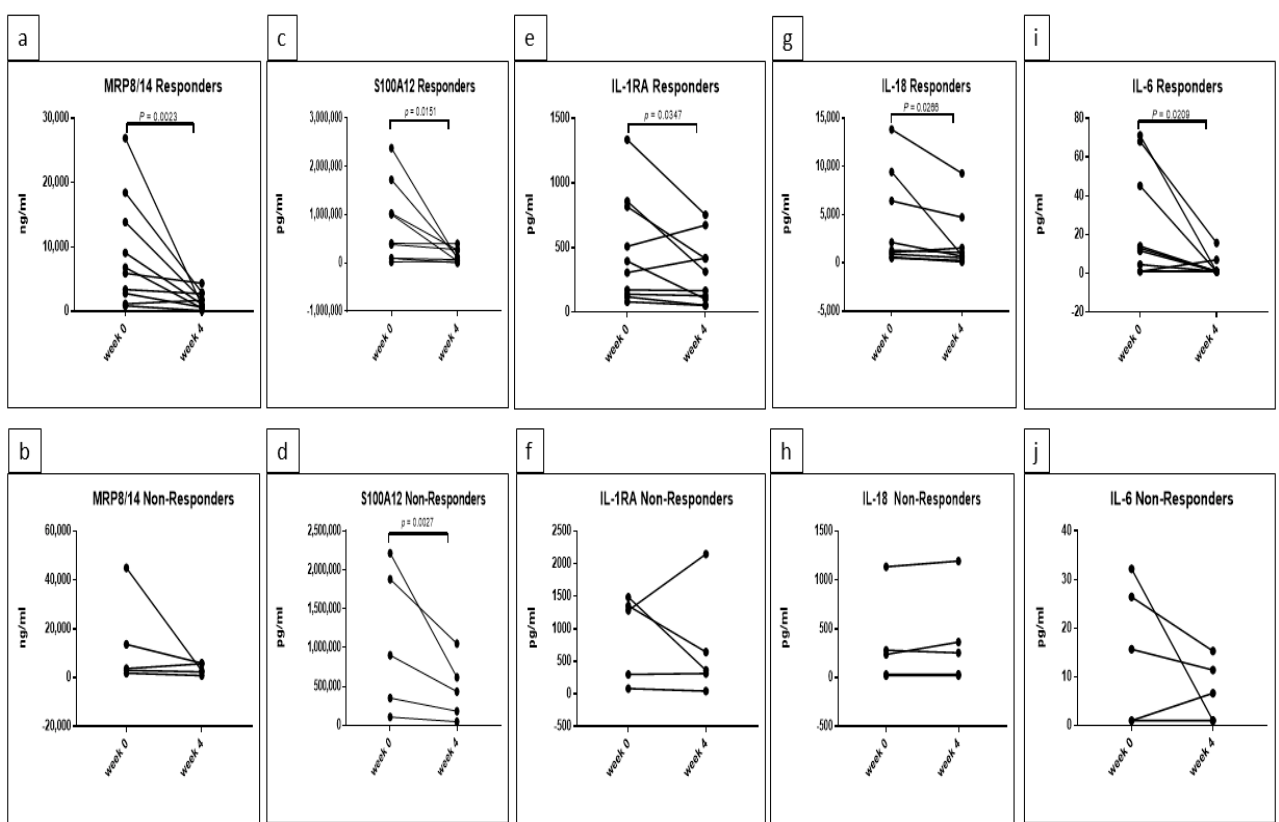
Figure 4. Confirmed significant reduction in MRP8/14 ( a , b ), S100A12 ( c , d ), IL-1RA ( e , f ), IL-18 ( g , h ) and IL-6 ( i , j ) in responders of canakinumab patients. Investigation of the effect of response rate in each responder and non-responder groups separately. Repeated-measures t -test was applied using GraphPad Prism 7 and statistical significance was set at p < 0.05.